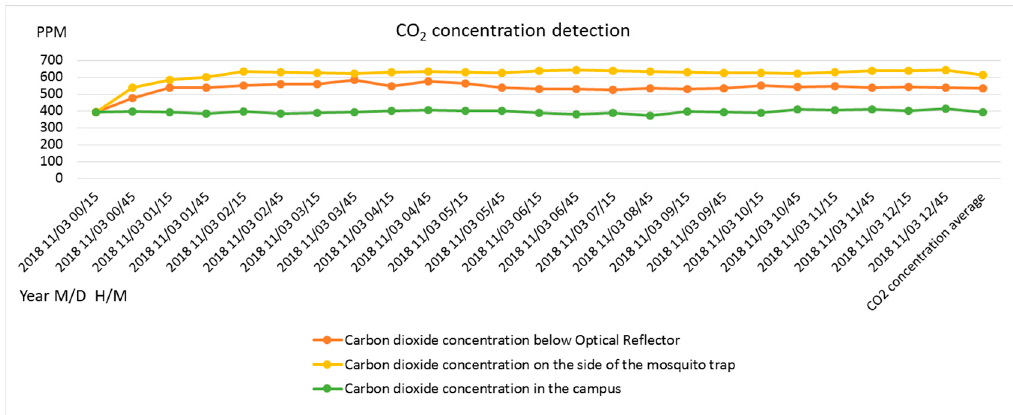
2 concentration.